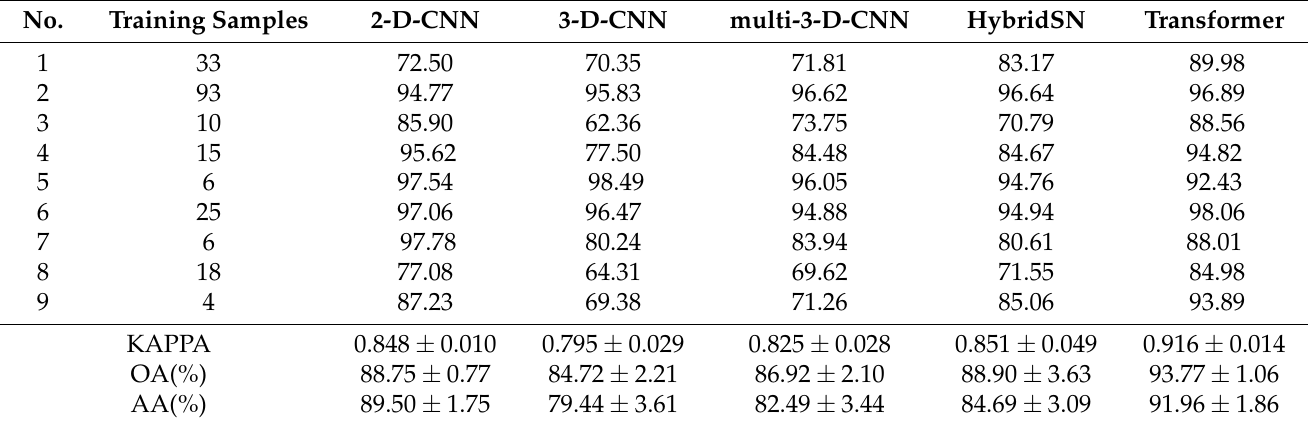
Table 10. Classification results of different models in the University of